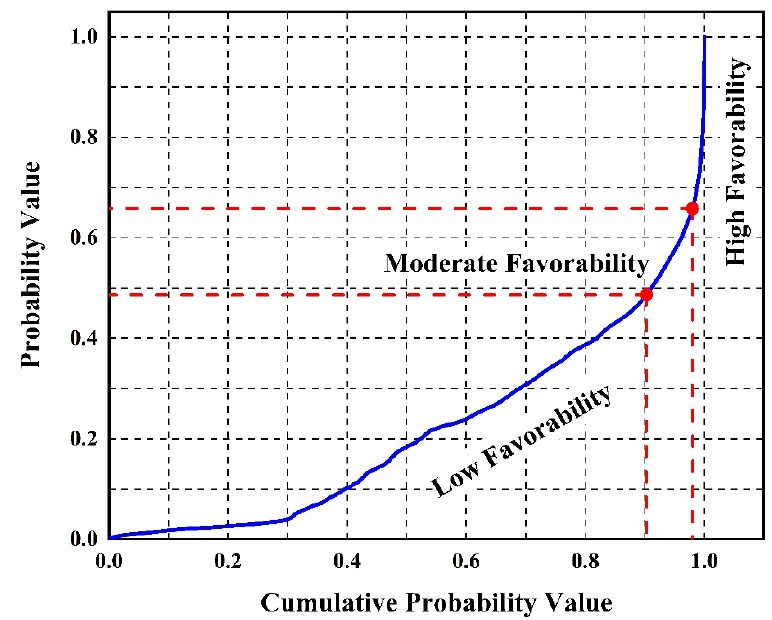
Figure 11. The probability values and the cumulative percentages for the study area.